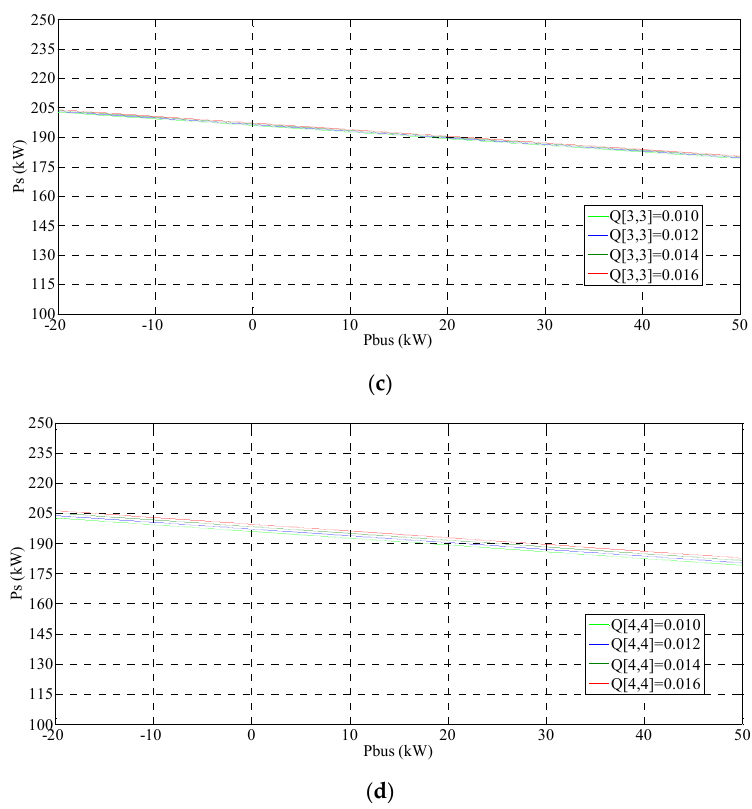
Figure 13. The sensitivity analysis of the weighting parameters: ( a ) The power transfer boundary under different values of k at Q [1,1]; ( b ) The power transfer boundary under different values of k at Q [2,2]; ( c ) The power transfer boundary under different values of k at Q [3,3]; ( d ) The power transfer boundary under different values of k at Q [4,4].